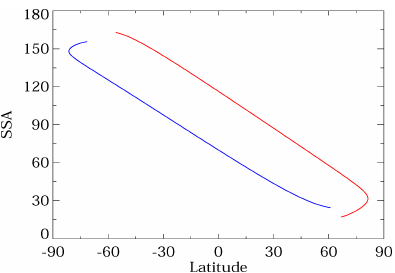
Figure 2. The single-scattering angle (SSA, or (cid:50) ) as a function of latitude for the SNPP OMPS LP instrument. June and December solstice conditions are illustrated by the red and blue lines, respec- tively. Note that near-polar latitudes may be observed twice (during the ascending and descending nodes of the orbit), which provides useful diagnostic